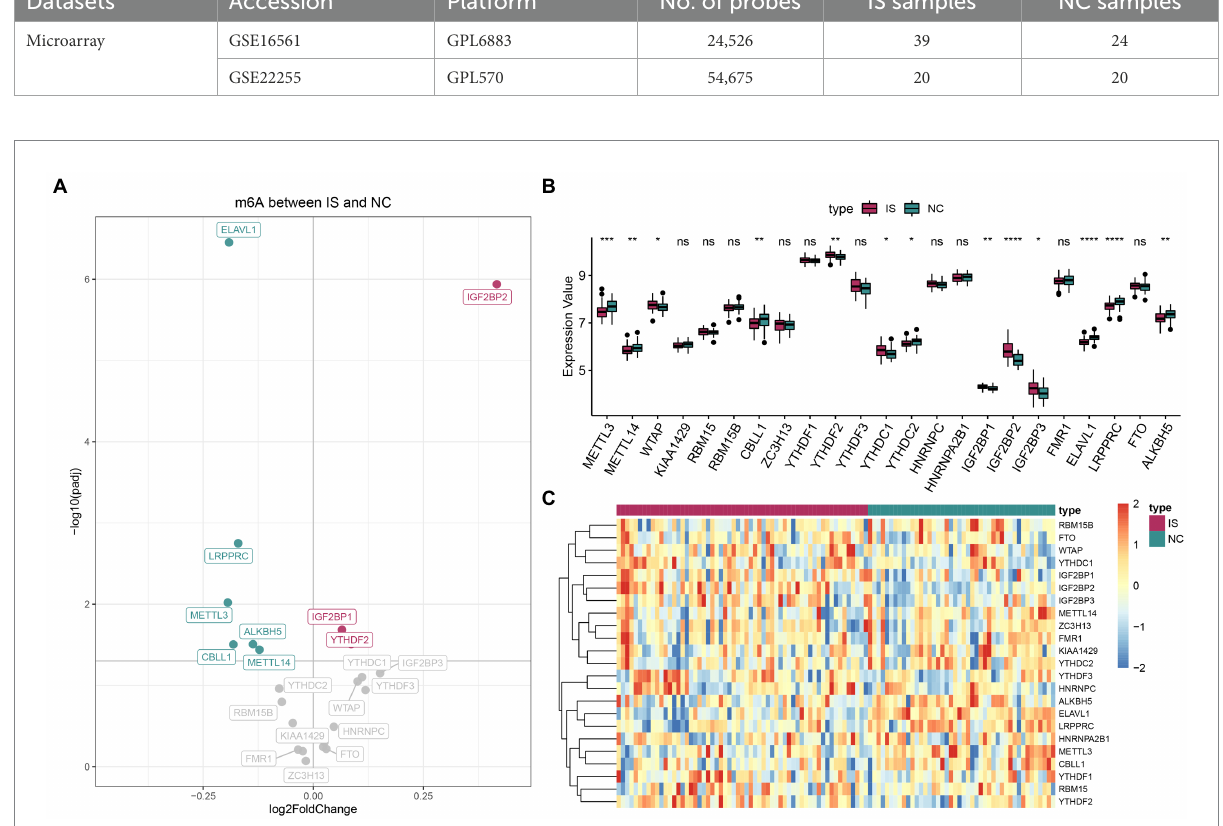
FIGURE 1 Expression landscape of N6-methyladenosine (m6A) regulators in ischemic stroke. (A) Volcano plot of m6A differential genes. (B) The boxplot of m6A regulators by the Wilcoxon test. (C) Expression heatmap of m6A regulators. ns: value of p ≥ 0.05; *: value of p < 0.05; **: value of p <